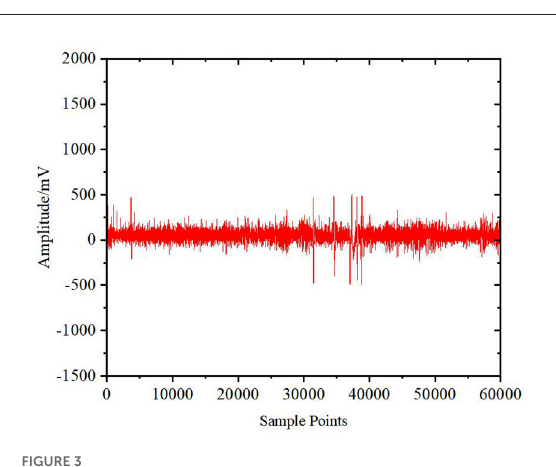
FIGURE5 Spectrogram after bandstop